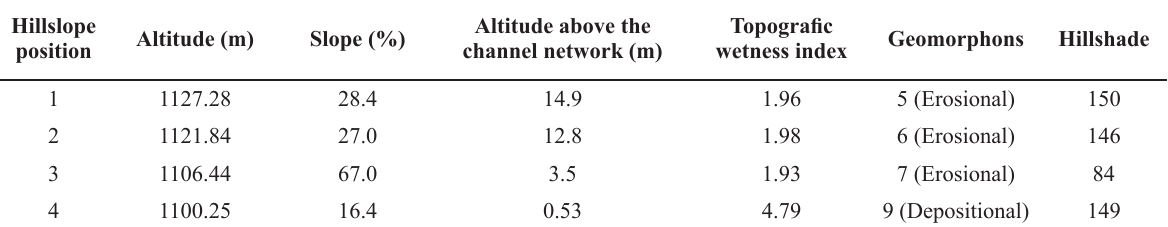
Altitude above the channel network (m)